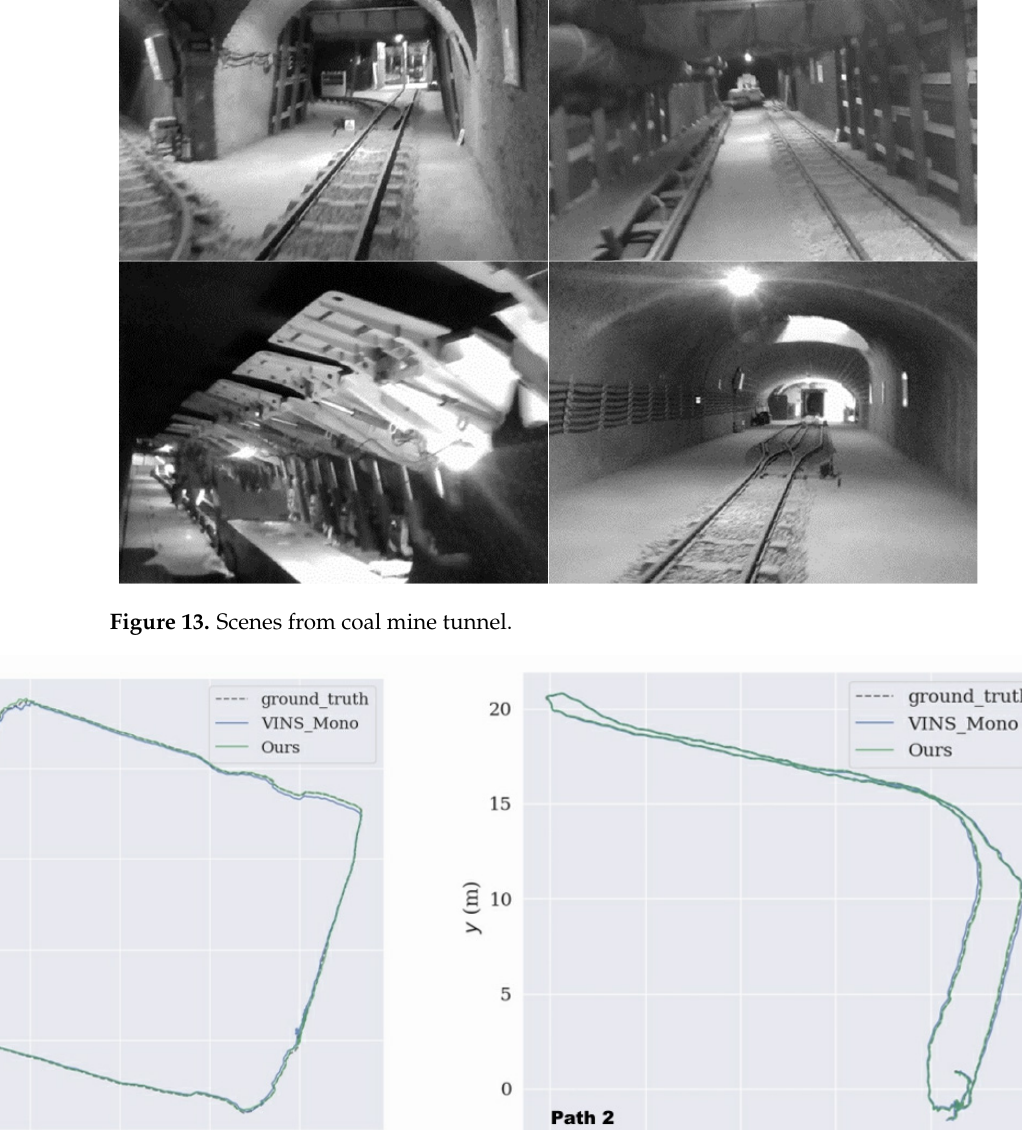
Figure 14. Trajectory error between the two algorithms and the true value under two paths. Table 4. Error statistics between the two algorithms and the true value under two